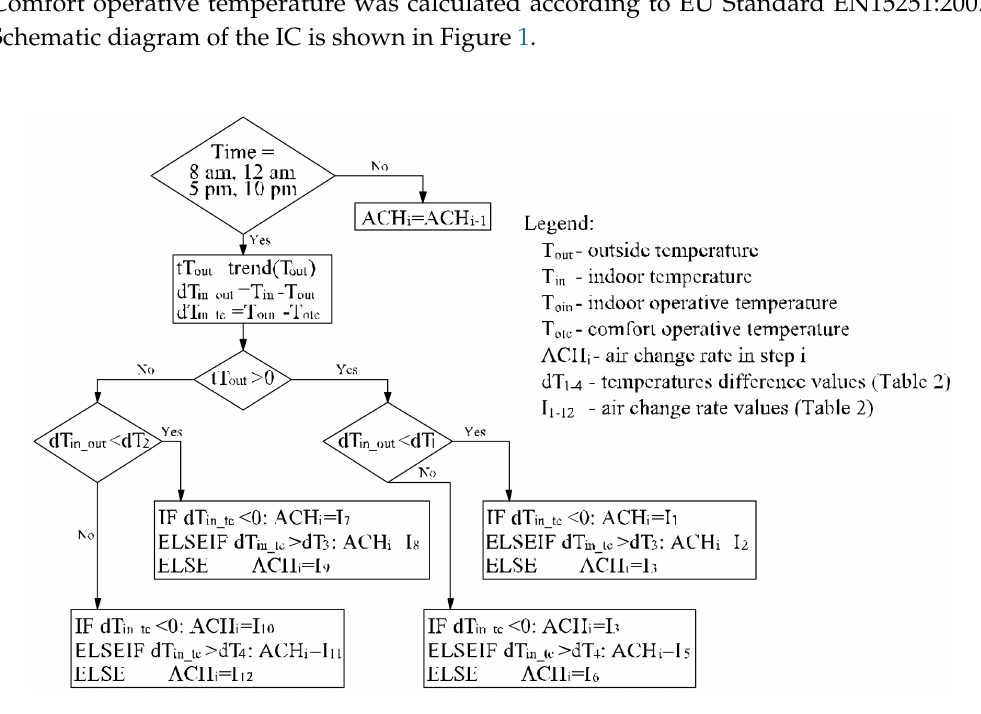
Figure 1. Flowchart diagram of the infiltration